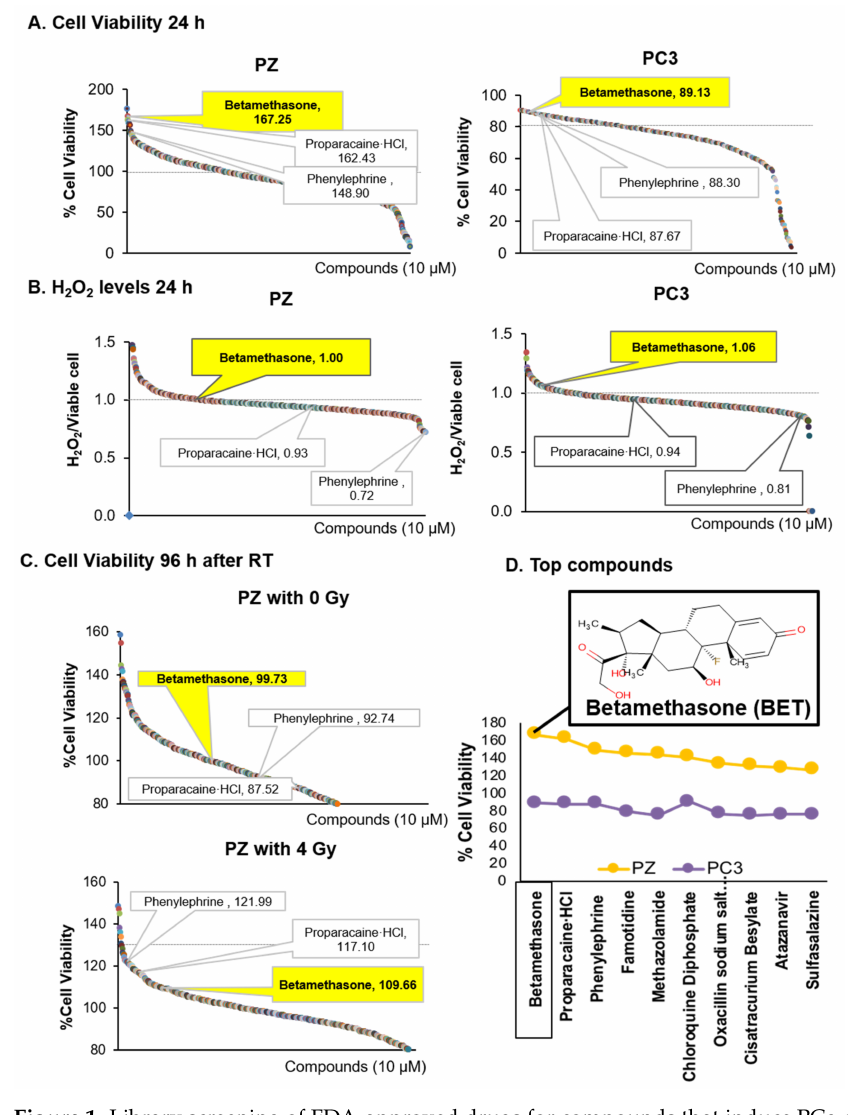
Figure 1. Library screening of FDA-approved drugs for compounds that induce PCa cell death while increasing non-cancer prostate cell viability through mediation of H 2 O 2 production. PC3 cells and PZ cells were treated with library FDA-approved drugs for 24 h. ( A ) Cell viability. ( B ) Extracellular H 2 O 2 based on Amplex Red assay. ( C ) Cell viability after drugs and radiation (4 Gy) treatment. Duplicate wells were tested per compound. ( D ) Drug candidates were chosen from a 786-compound library based on H 2 O 2 production and the ability to exert opposite cytotoxic effects on non-cancer and cancer cells. One dot represents one compound. Please see supplementary excel file for details of each